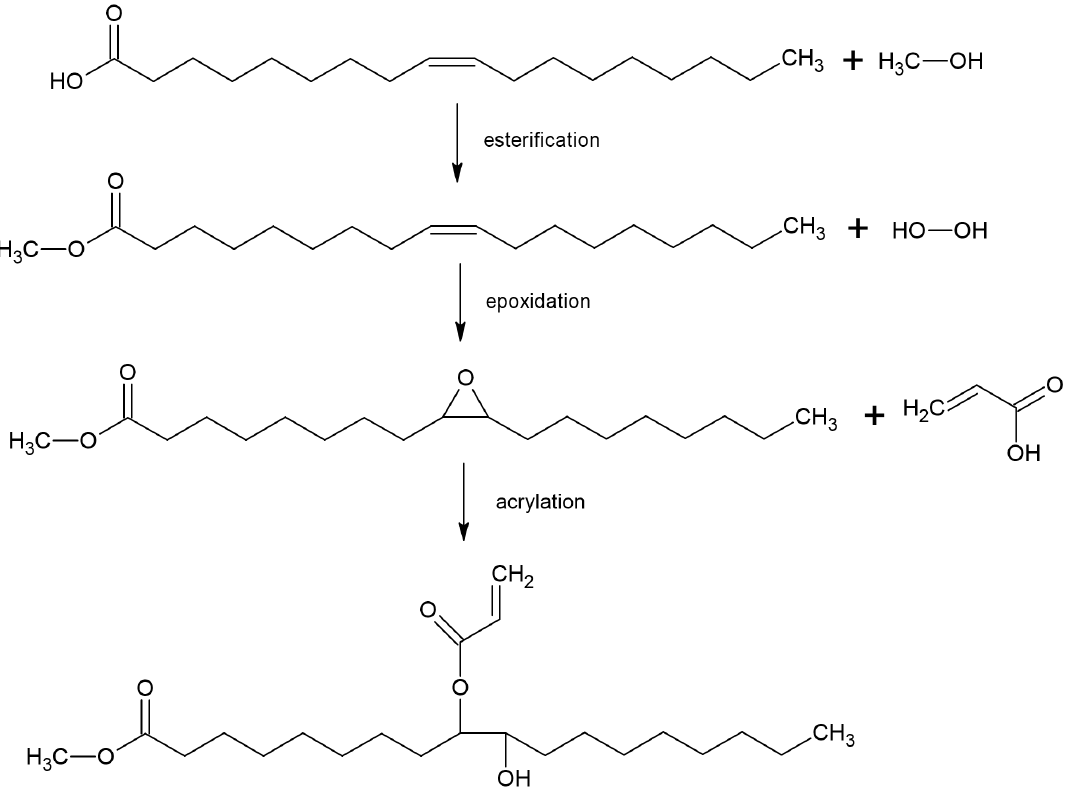
Figure 1. Schematic illustration of AME_OA synthesis from oleic acid.